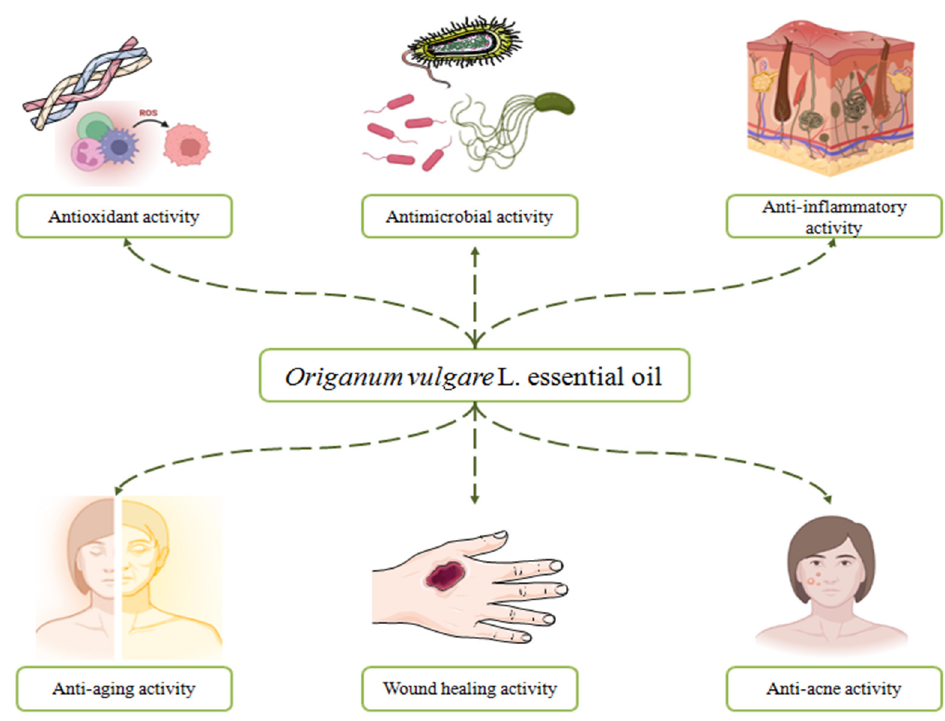
Figure 9. A snapshot of the cutaneous effects of Origanum vulgare L. essential oil.